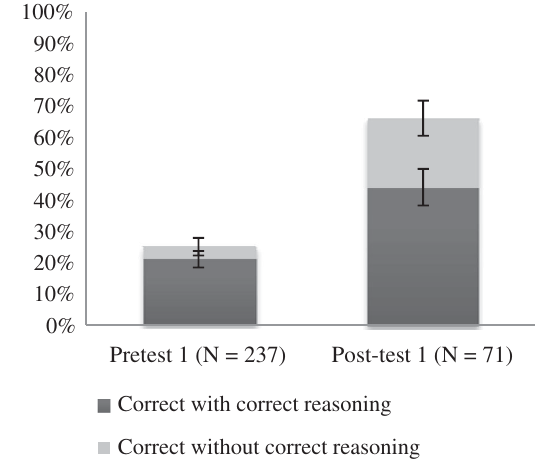
FIG. 3. Student performance on question 1, before and after completion of the tutorials. Error bars represent the standard error.